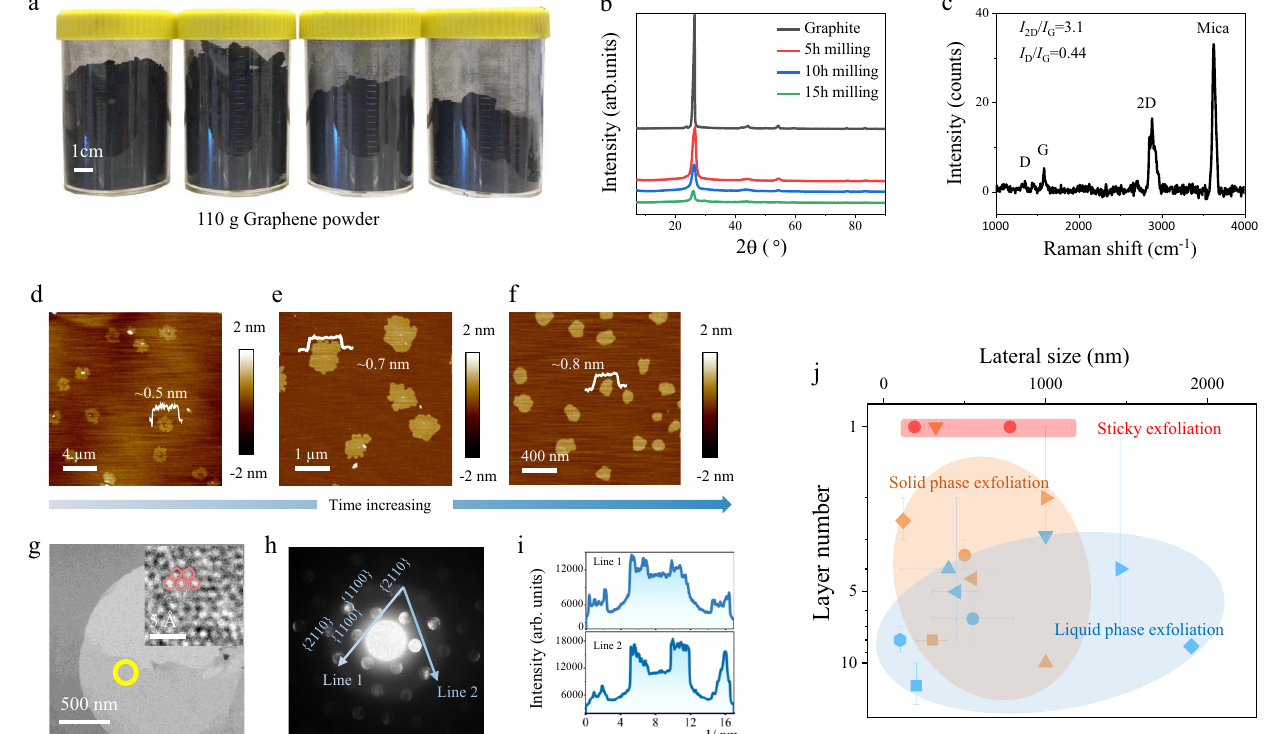
Fig. 1 | The physical properties of the graphene nanosheets via sticky mechanical exfoliation. a Photograph of the obtained 110g graphene in powder form. b Powder X-ray powder diffraction (XRD) patterns of pristine graphite and graphene products after5,10, and 15h milling. c AccumulatedRamanspectrum of the graphene nanosheets after 15h milling deposited on mica. Detailed char- acterizationmethodcanbefoundinsupplementaryS2.4. d – f Selectedatomicforce microscopy (AFM) height pro fi les of graphene exfoliated by 5, 10, and 15h milling, respectively (from left to right). g High resolution transmission electron micro- scopy (HR-TEM) image of exfoliated graphene (inset, atomic resolution).